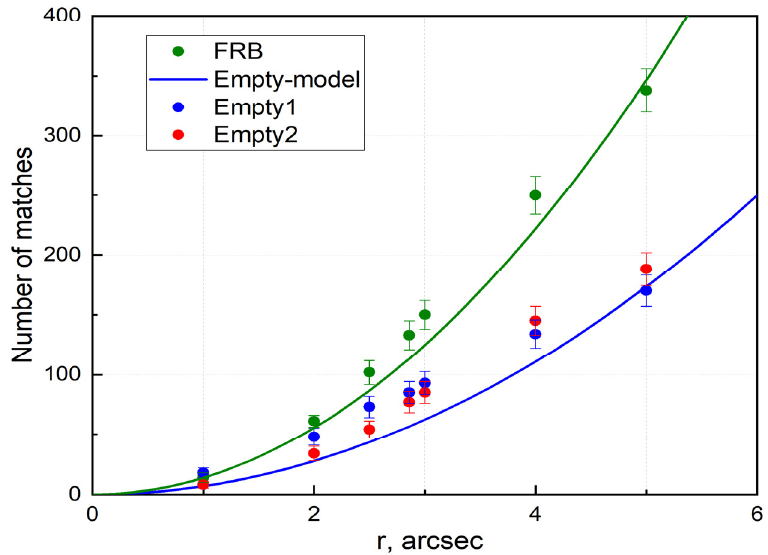
Figure 3. The dependence of the number of synchronous coincidences in both tubes at the level of 3 sigma on the radius of the circular analyzed region in angular units. Green dots show the area around the FRB 180916.J0158+65. Green and blue curves are expected theoretical results for an object and an empty place.